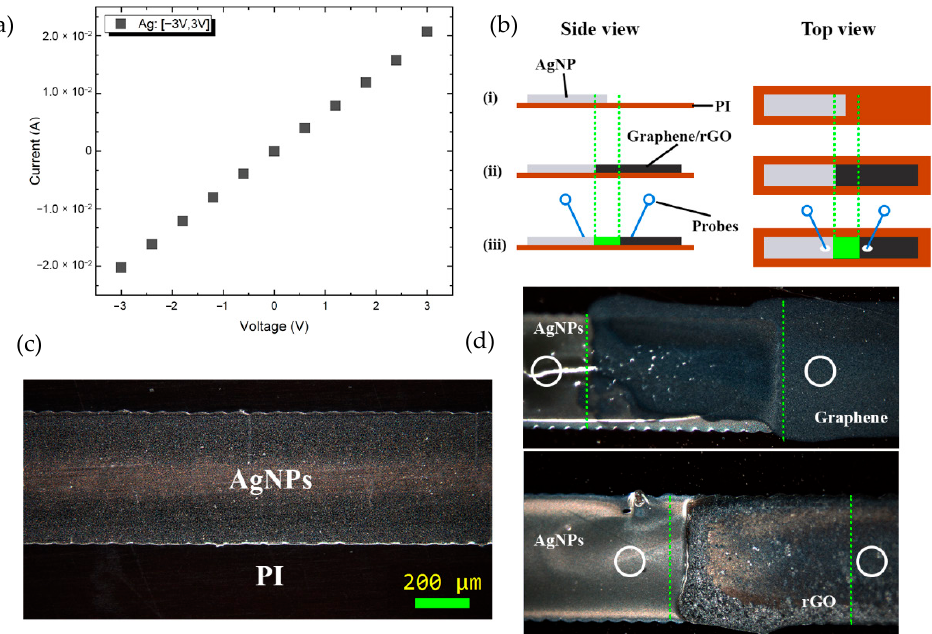
Figure 7. IV curve of printed AgNP line ( a ); printed AgNP line optical microscope image ( b ); experimental process for the contact between G/ f -rGO ink and AgNP: printed AgNP (i), printed graphene and f -rGO inks with an overlap area depicted in green (ii), probes position for measuring electrical resistance (depicted in white) (iii) ( c ); f -Rgo–AgNP contact optical microscope images. Green lines indicate the total overlap area, while white circles indicate the approximate probe position for measurements ( d ).